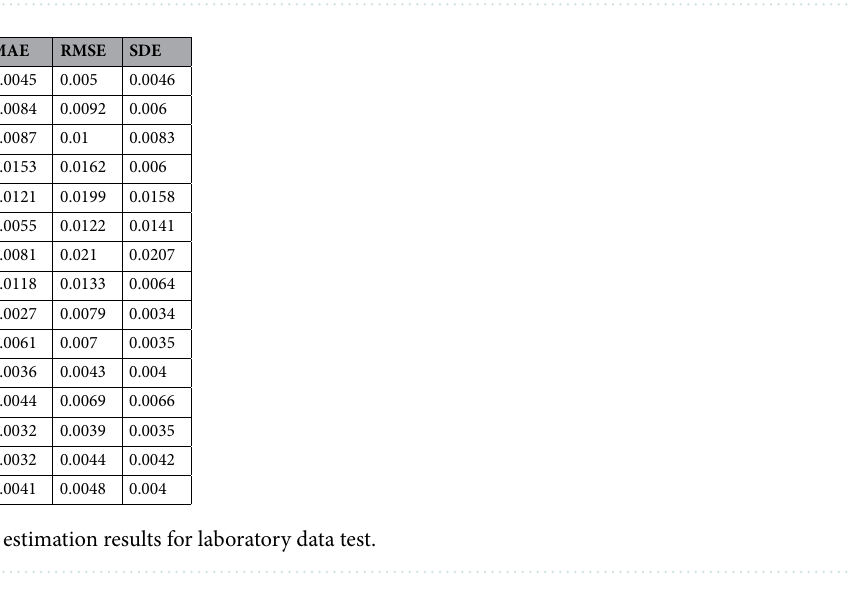
Figure 3. (cid:31) V r vs (cid:31) SOH plot for different charge profiles at ( a ) 30% SOC, ( b ) 40% SOC, ( c ) 50% SOC.